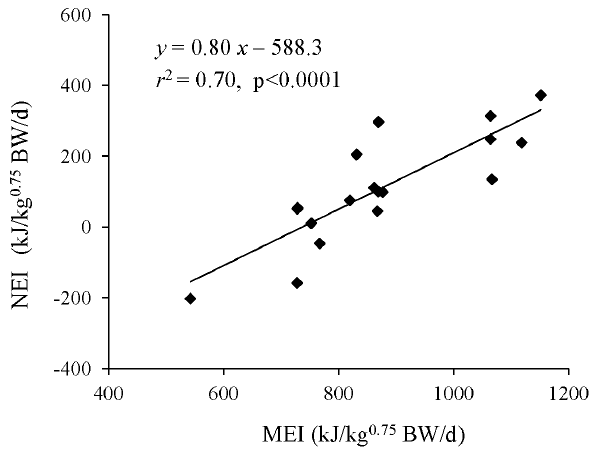
Figure 1. Linear regression of net energy intake (NEI, y ) and metabolizable energy intake (MEI, x ) of calves (mean BW, 148.4 kg) in Trial 1. NEI was estimated as MEI – heat production (HP). Metabolizable energy for maintenance was the interpolant of x at the point where y is 0.